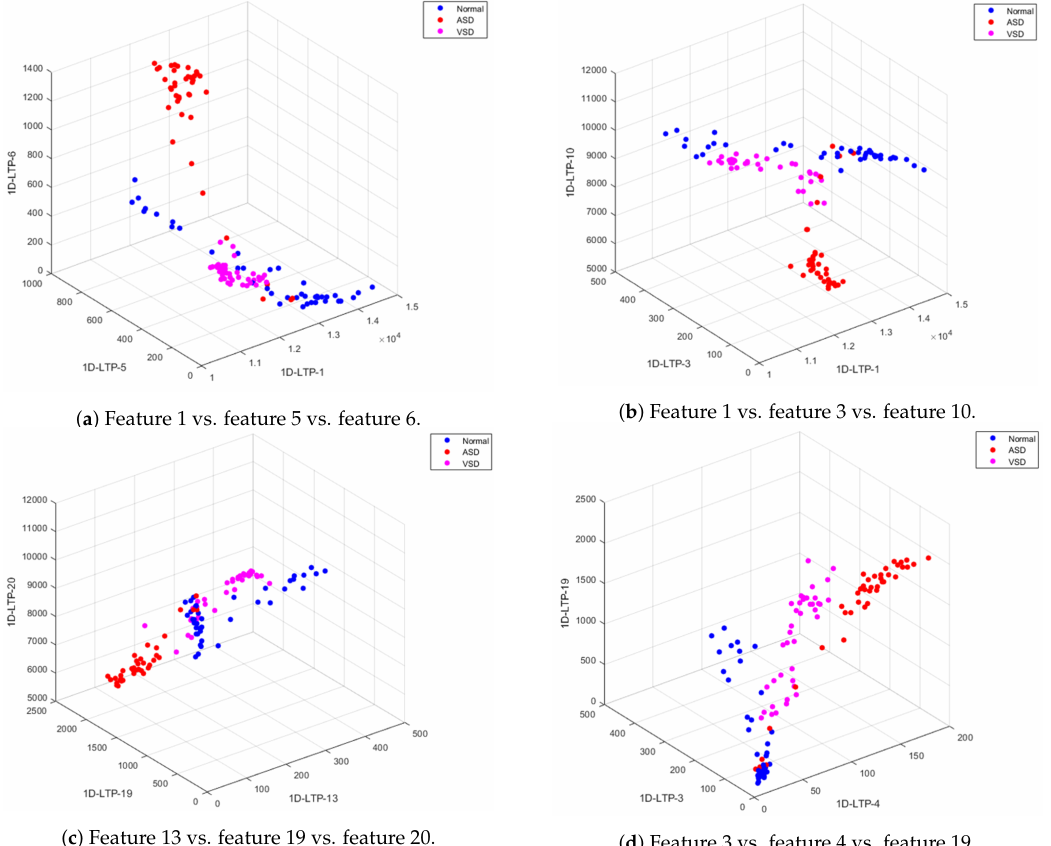
Figure 9. Scatter plots of 1D-LTP features.